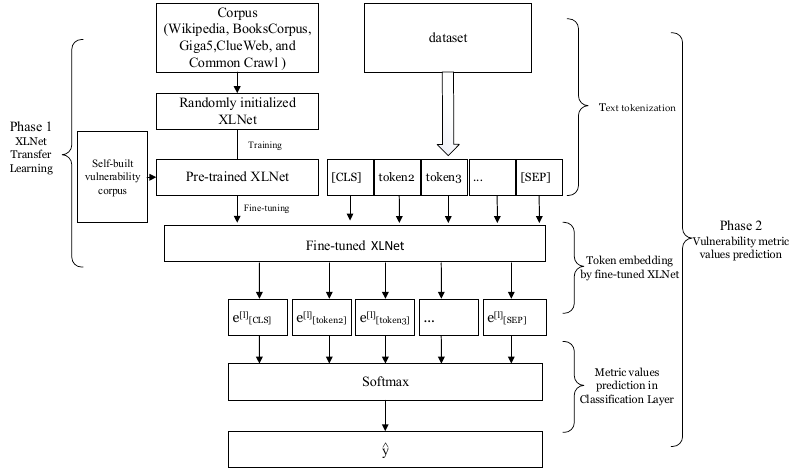
Figure 3. The architecture of the fine ‐ tuned XLNet model.